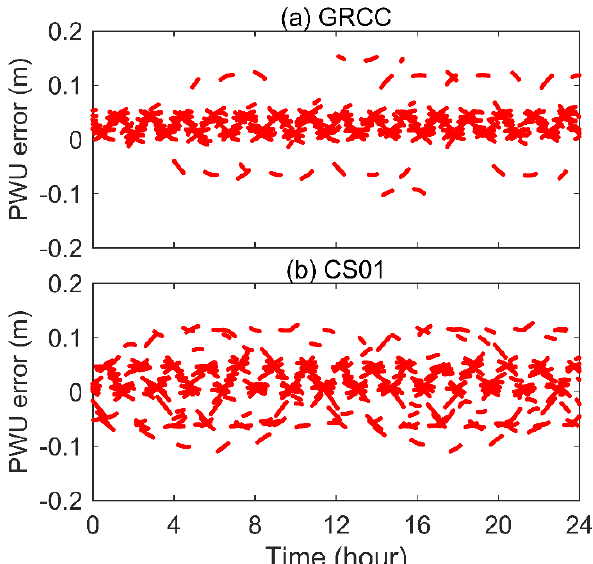
Figure 7. The PWU variations for GRCC and CS01 in DOY 273, 2018.